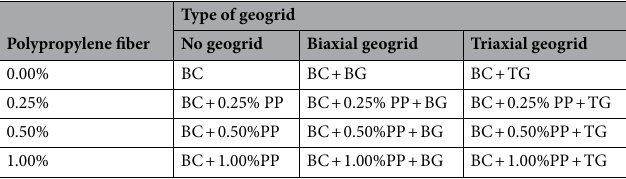
Table 5. Reinforced and unreinforced section considered.